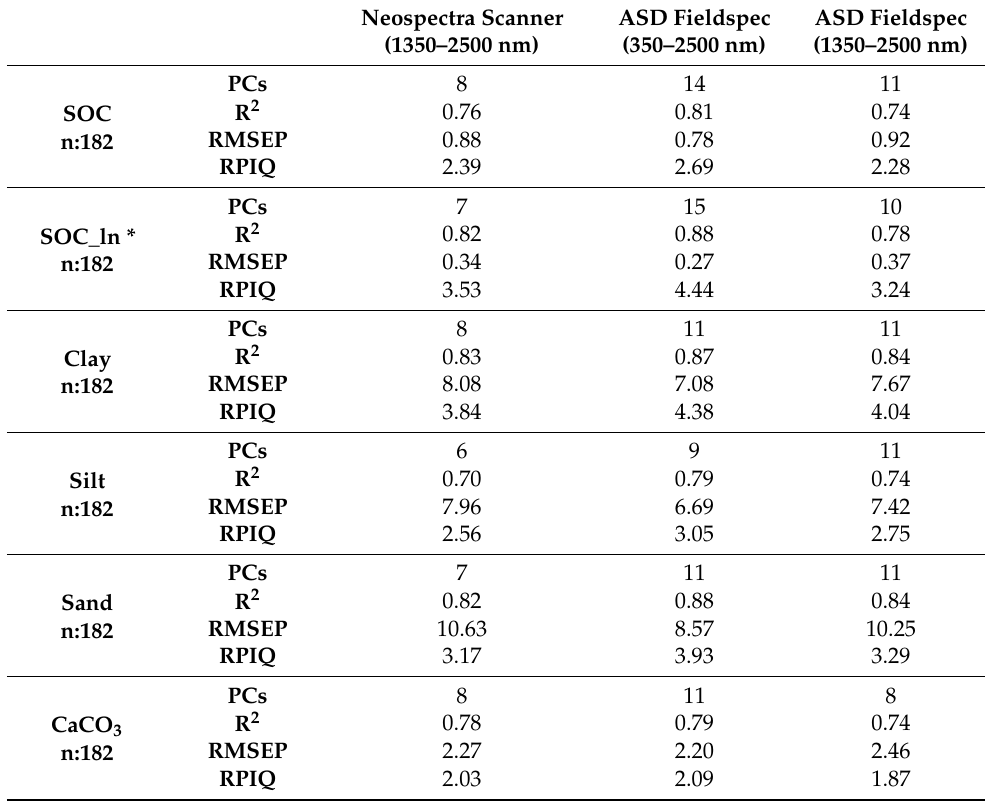
Table 2. Results of 10-fold cross-validation of the PLSR models for prediction of SOC, Clay, Silt, Sand, and CaCO 3 , using the spectra of the Neospectra Scanner, the whole spectrum of ASD Fieldspec, and the NIR bands 1350–2450 nm of ASD Fieldspec spectrum. PCs represent the number of principal components (or latent variables) used by the PLSR. *: the logarithmic transformation of SOC, to obtain a quasi-normal data distribution. The unit measure of all the variables was g · 100 g − 1 . Neospectra